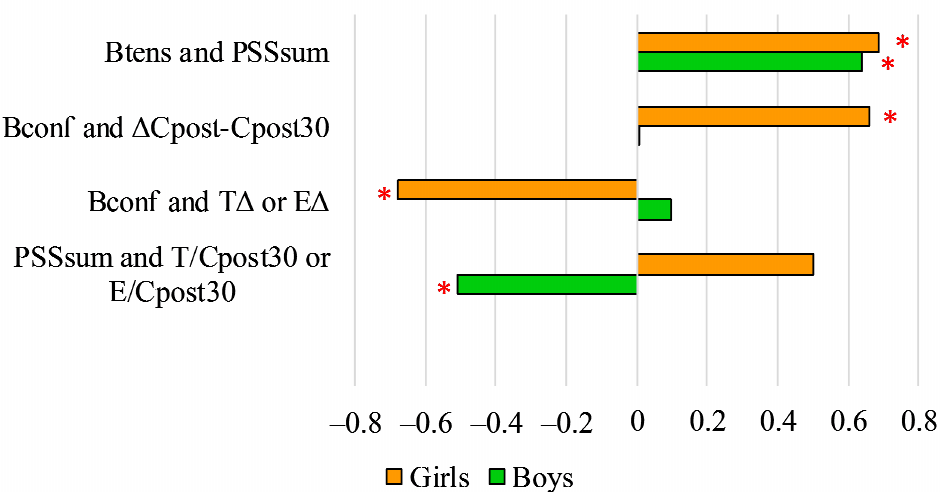
Figure 5. Pearson’s correlation coefficient (r) values of PSS and BRUNEL questionnaire items and other psychological and physiological variables (* p < 0.05). Btens: score of tension on the BRUNEL scale; Bconf: score of confusion on the BRUNEL scale; PSSsum: sum of Perceived Stress Scale scores; ∆ Cpost-Cpost30: C difference of cortisol levels after the field test and 30 min after the field test; T ∆ : difference of testosterone levels before the field test and 30 after the field test; E ∆ : difference of estradiol levels before the field test and 30 after the field test; T/Cpost30: testosterone/cortisol ratio 30 min after the field test; E: estradiol; E/Cpost30: estradiol/cortisol ratio 30 min after the field